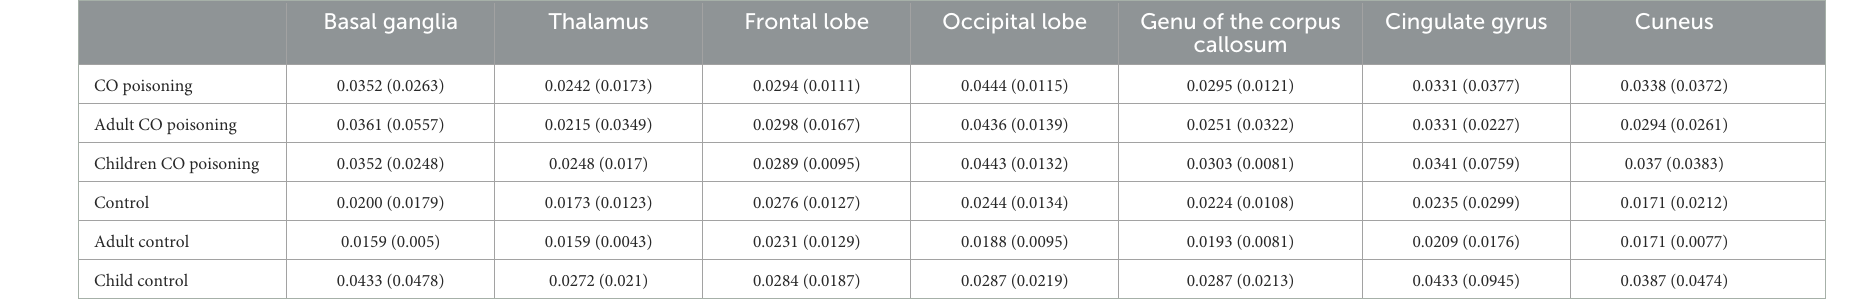
TABLE 2 GluCEST in each region of interest.